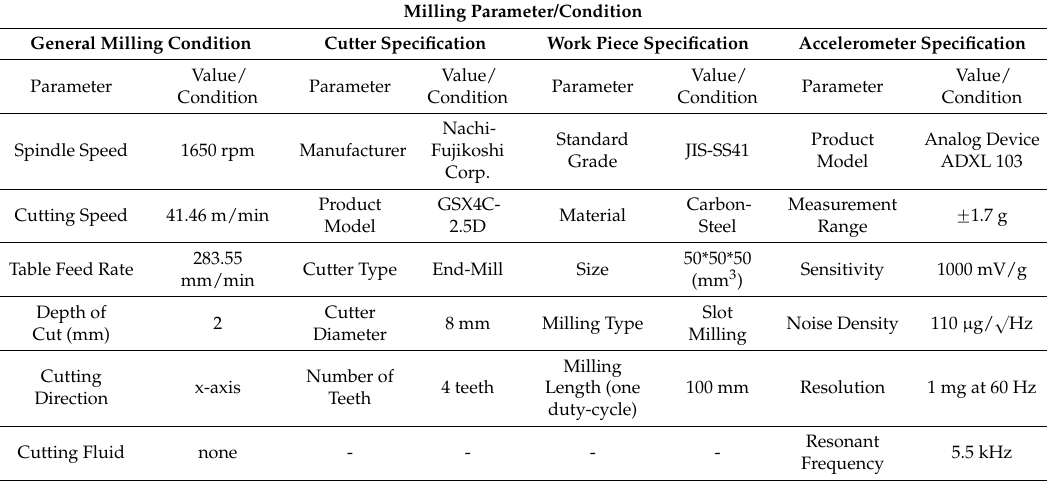
Table 2. The rotational-speed-dependent milling parameters/conditions for the milling-processes